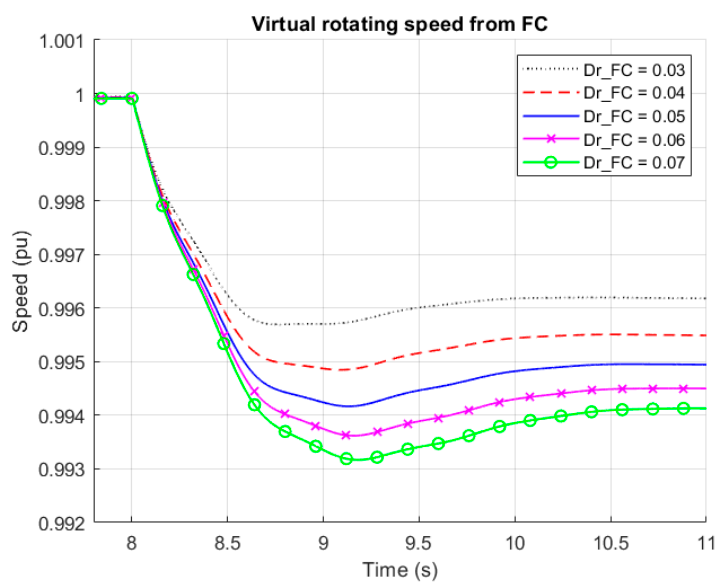
Figure 5. Influence of the droop coefficient D r on the virtual rotating speed of FC (H_FC = H_SG = 4 W · s/VA, D r _ SG = 0.05).